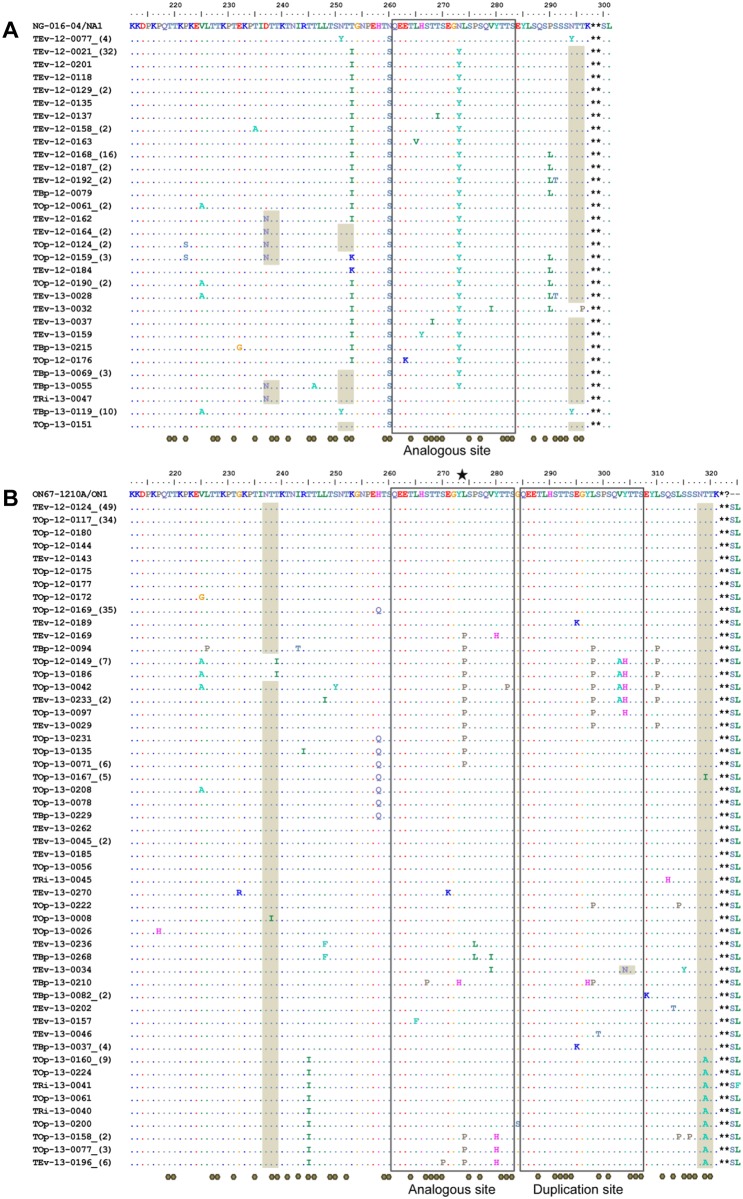
Deduced amino acids of representative HRSV-A G protein in 2012–2013.(A) Thirty-one representative unique NA1 amino acid sequences corresponding to position 212 to 301 of the 2nd HVR of G protein were aligned with the prototype NA1 strain, NG-016-04 (AB470478). (B) Fifty-two representative unique ON1 amino acid sequences corresponding to position 212 to 325 of the 2nd HVR of G protein were aligned with the prototype ON1 strain, ON67-1210A (JN257693). Gray shading for predicted N-linked sites, gray octagons for predicted O-linked sites, dots for identical residues, asterisks for stop codon positions, star for positive selection position, boxes for analogous sites/duplication sites, and parenthesis for number of identical strains are indicated.